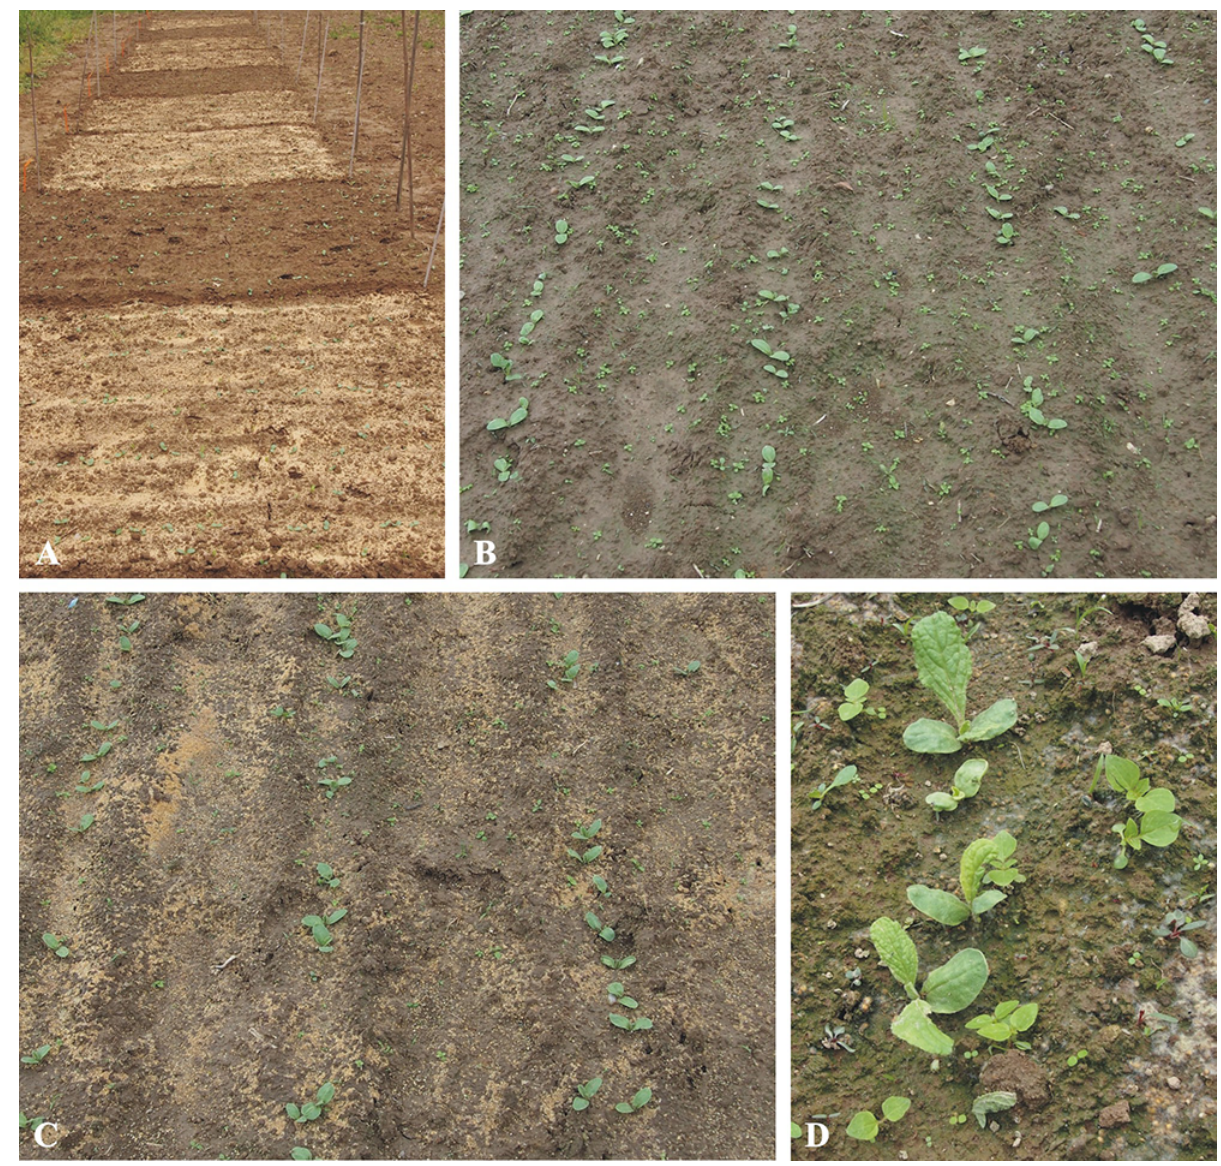
Figure 1 ( A ) General view on experimental plots during borage emergence. ( B ) Emergence of borage and weeds on control plot. ( C ) − 1 Emergence of borage and weeds on plot treated with 3 t MSM ha . ( D ) Chlorosis and deformation of cotyledons and first leaves of − 1 borage on plot treated with 3 t MSM ha